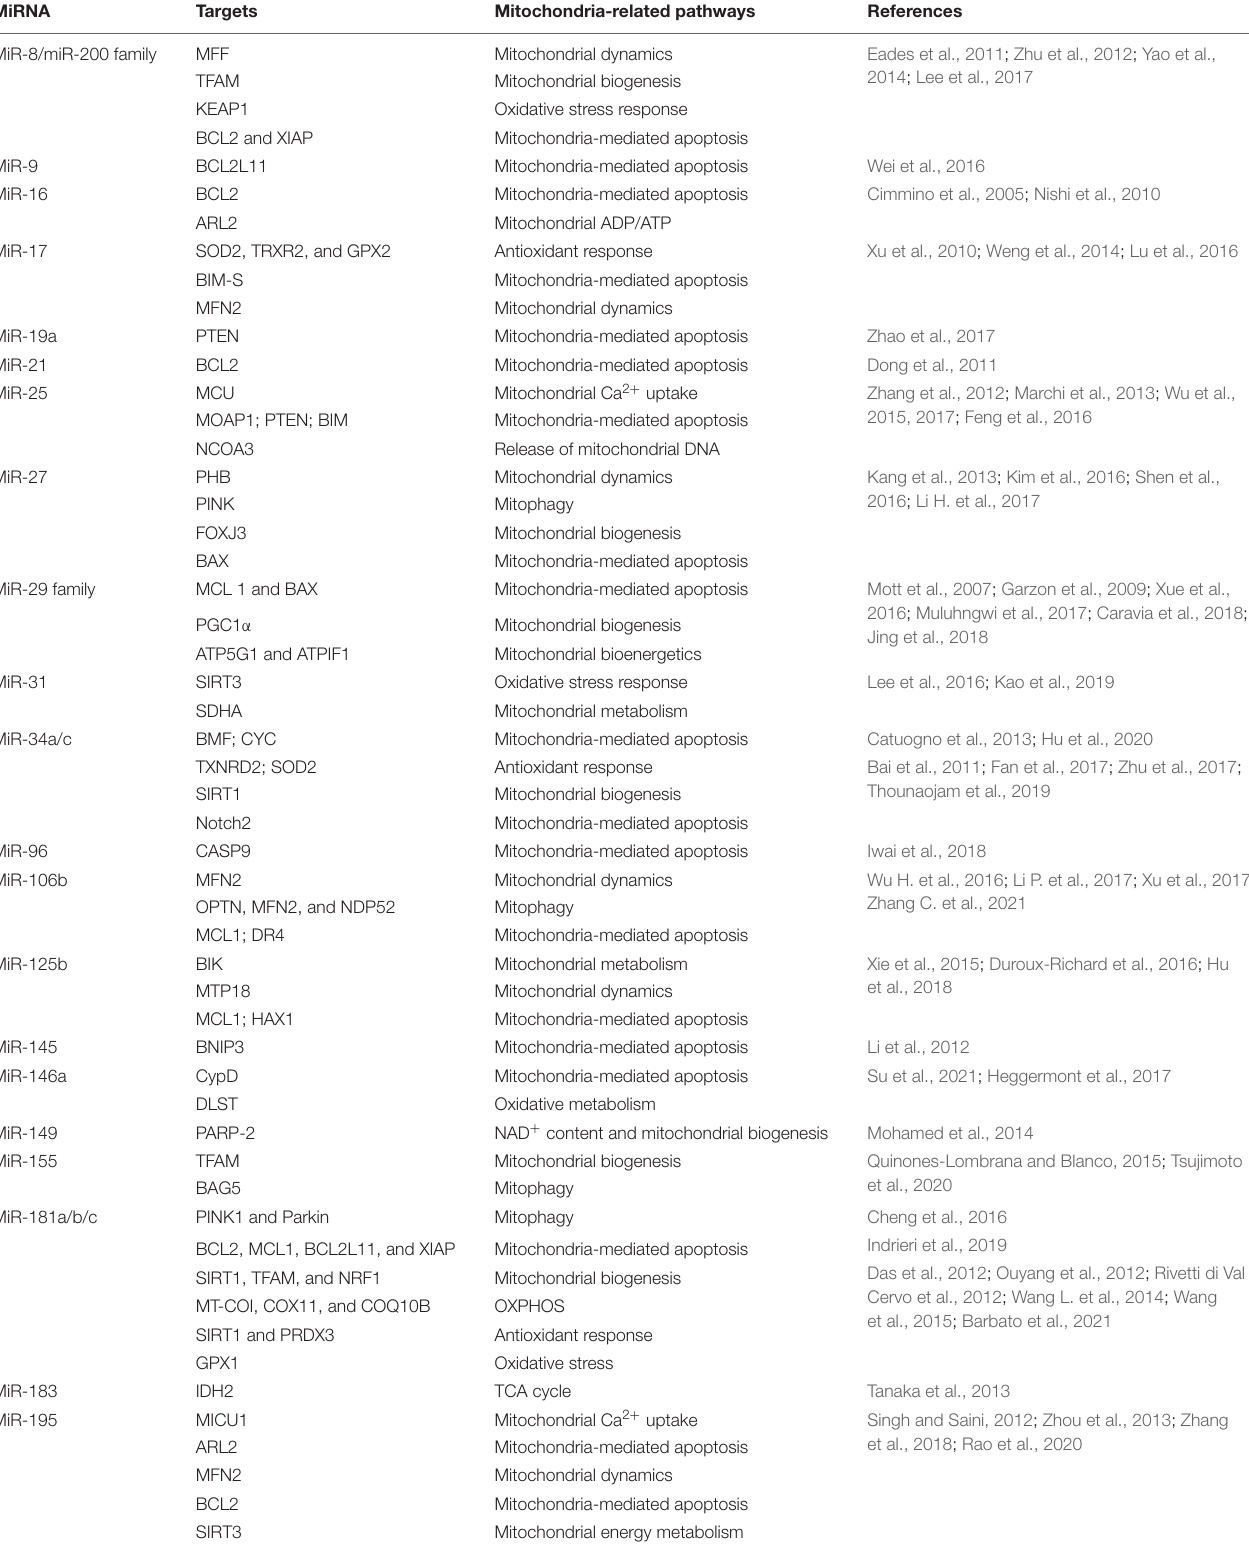
TABLE 2 | Mitochondrial-related targets and pathways modulated by